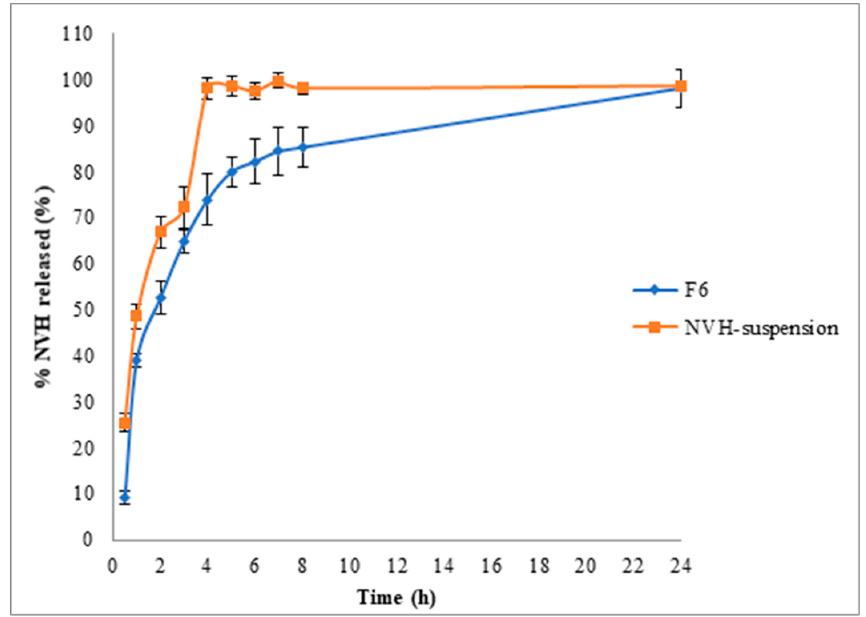
Figure 2. Release profile of NVH from ( a ) optimal chitosomal formulation F6; ( b ) NVH suspension in